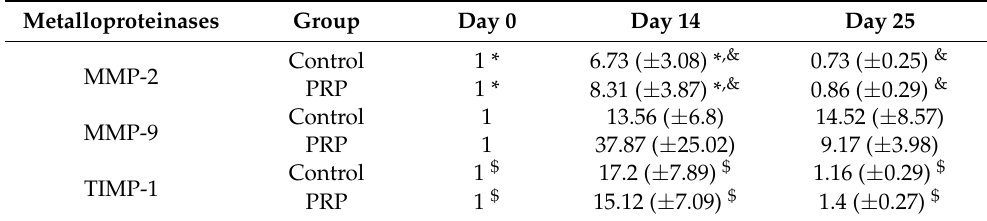
Table 6. Metalloproteinases-2 and -9, and TIMP-1 activity in the PRP and control groups on days 0, 14, and 25 in the eight